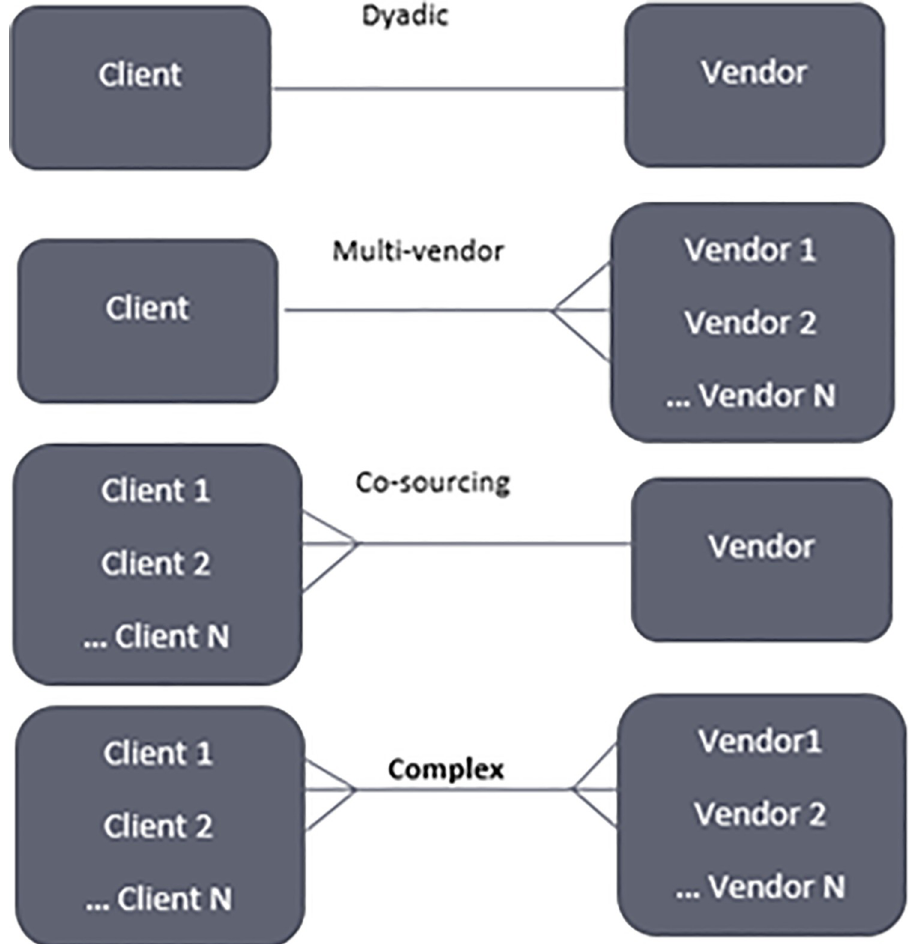
Fig 1. Types of outsourcing